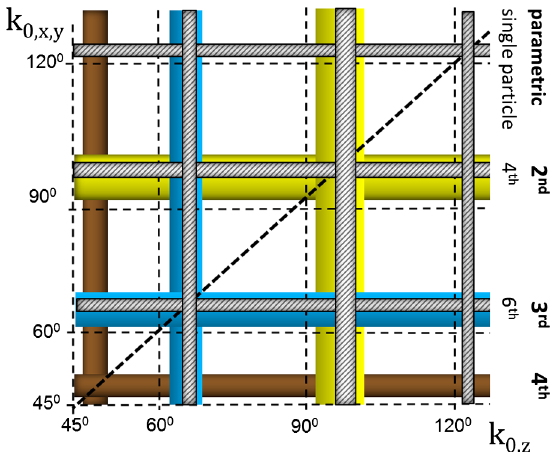
FIG. 12. Schematic stability diagram showing the location of transverse space charge driven 2nd to 4th order parametric resonances; and relevant 4th and 6th order single particle resonances (hatched, uncoloured